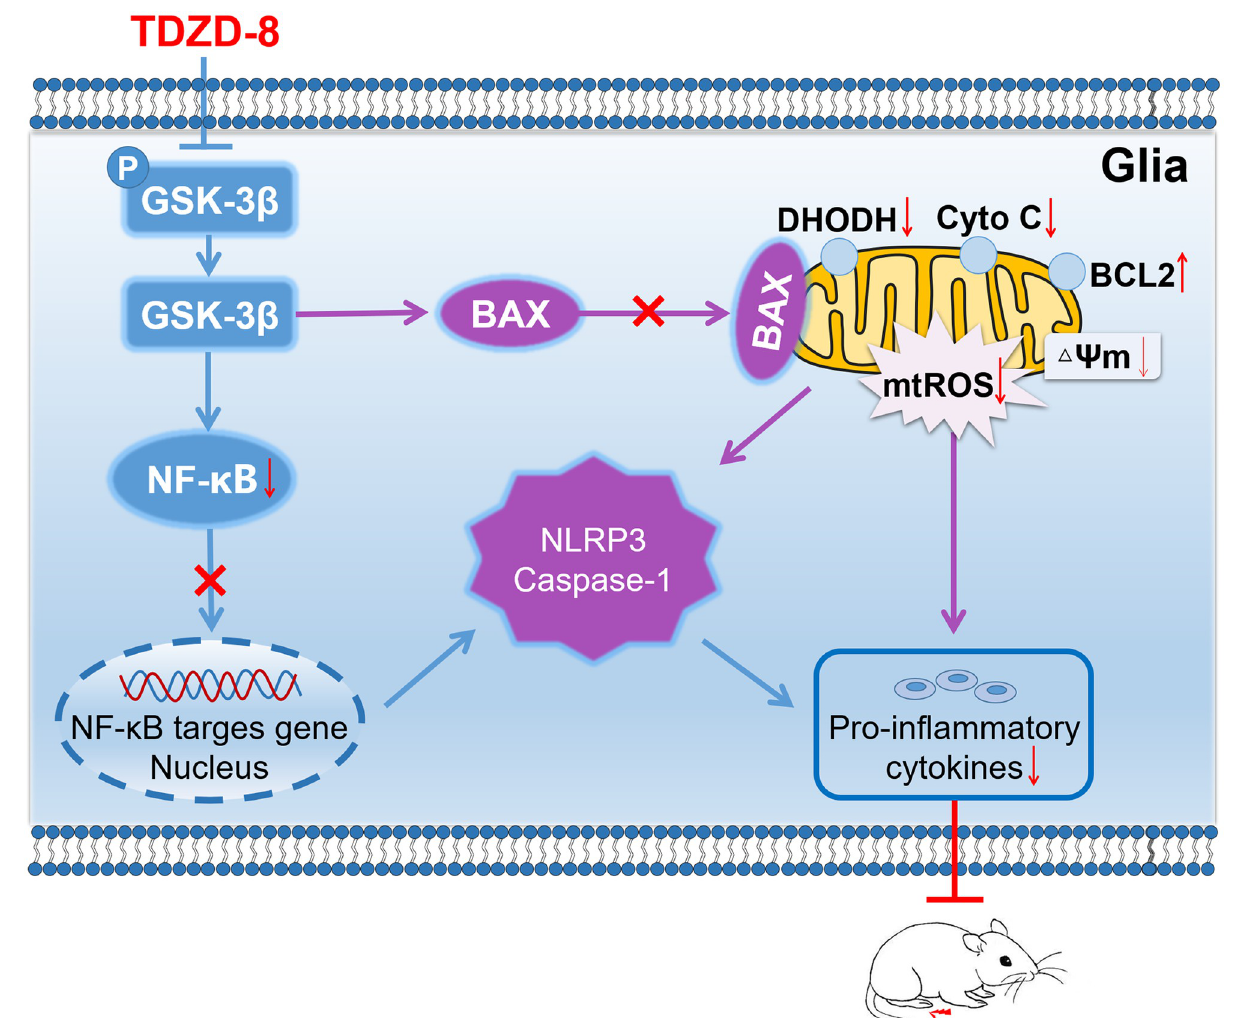
Fig 6. Schematic representation of the potential mechanisms of TDZD-8 treatment on alleviating arthritis pain.